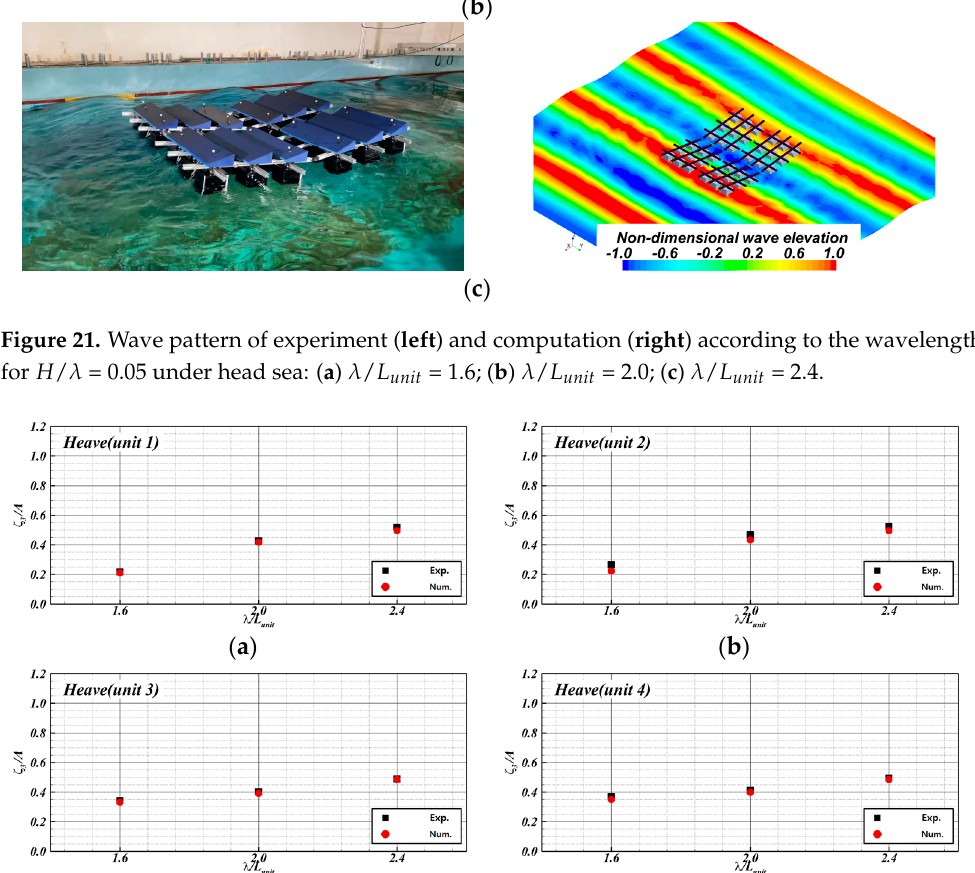
Figure 21. Wave pattern of experiment (left) and computation (right) according to the wavelength for 𝑯/𝝀 = 0.05 under head sea: ( a ) 𝝀/𝑳 𝒖𝒏𝒊𝒕 = 1.6; ( b ) 𝝀/𝑳 𝒖𝒏𝒊𝒕 = 2.0; ( c ) 𝝀/𝑳 𝒖𝒏𝒊𝒕 = 2.4.